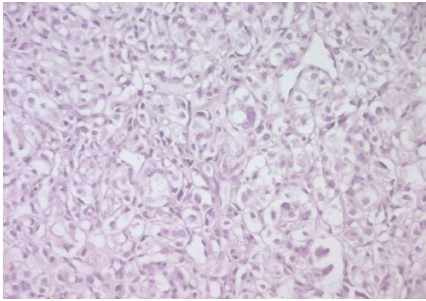
Figure 2: (HEx200) Tumor cells arranged in nests and trabecular patterns surrounded by an endocrine stroma.